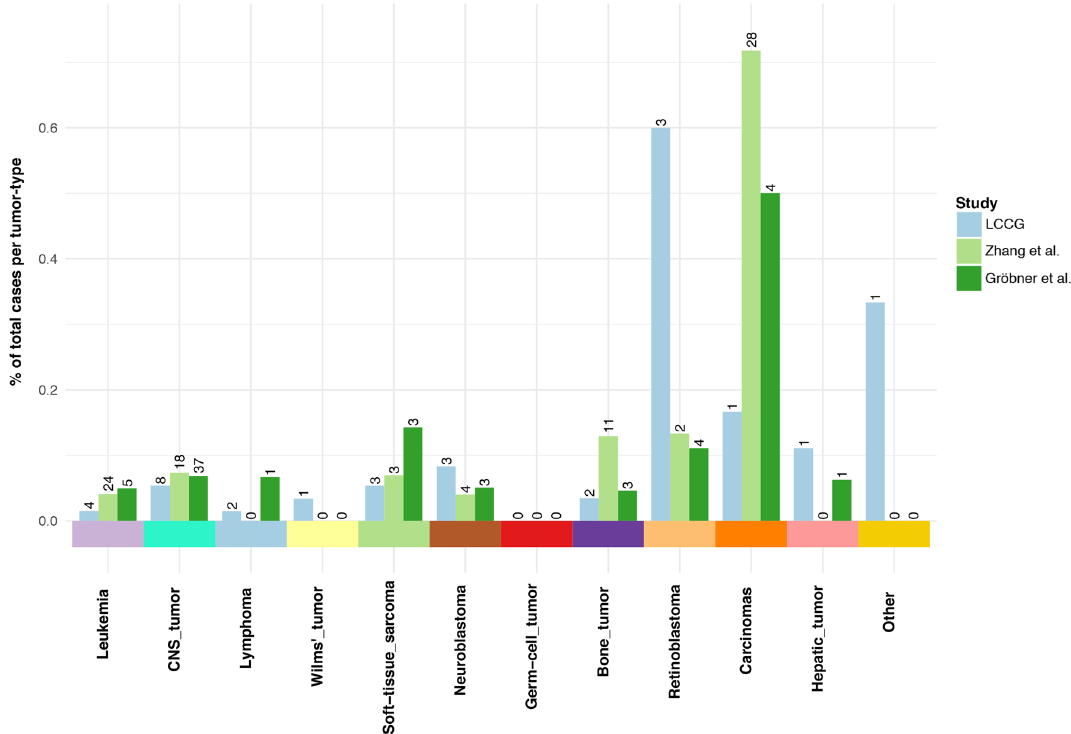
Figure 3. Mutation prevalence per tumor-type. Distribution bar-plot of LCCG, Zhang et al. and Gröbner et al. cohorts divided according to diagnosis. Number of (likely) pathogenic variants in each cohort diagnosis group is displayed above each bar. Comparative statistics are provided in Supplementary Table